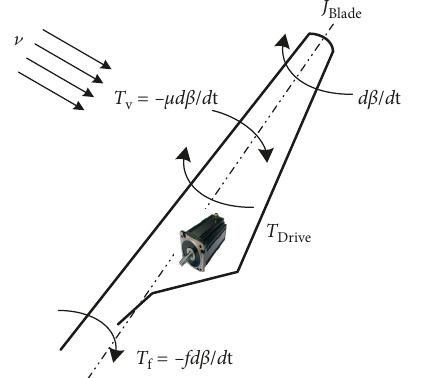
Figure 9: Internal components of generator cabin.